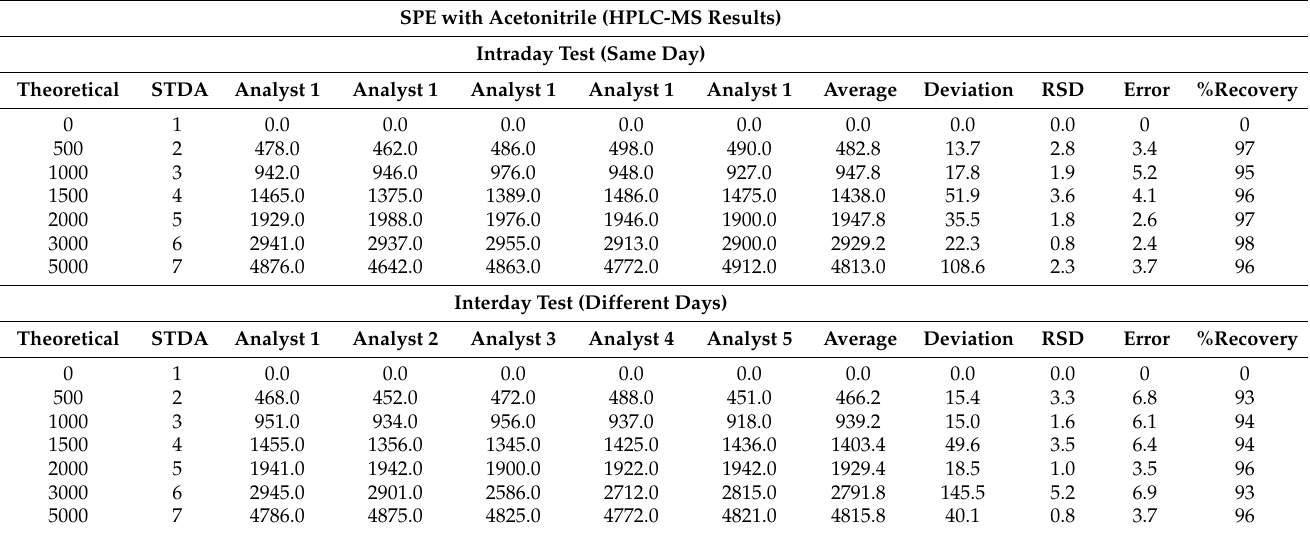
Table 2. Tabulation of data for repeatability and reproducibility of standards in the